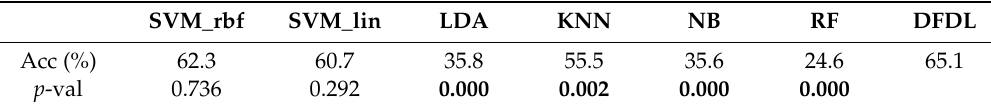
Table 2. Average Classification Accuracies for Amputee Subjects.